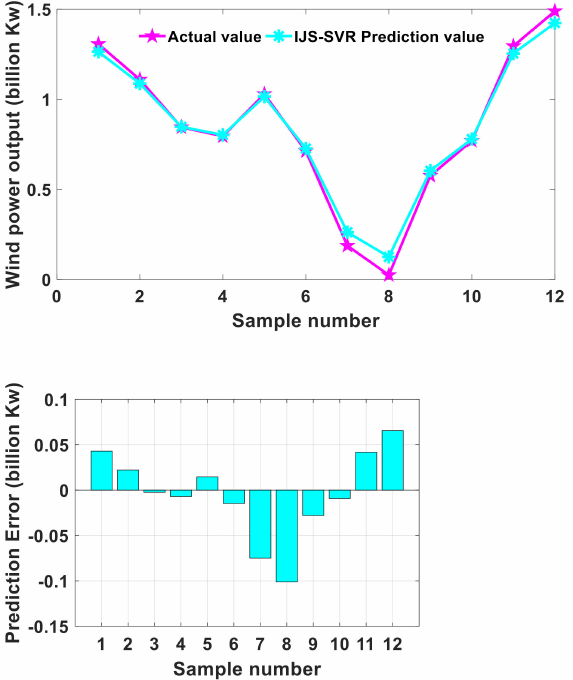
Figure 8. The prediction results and error of the IJS-SVR prediction model for the wind